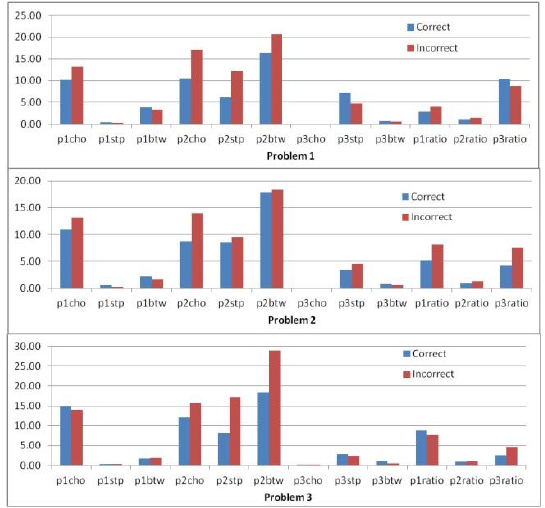
Figure 6. Average numbers and ratios of fixational transitions in each phase of each problem and each group. p=phase, cho=within-choices, stp=within-steps,